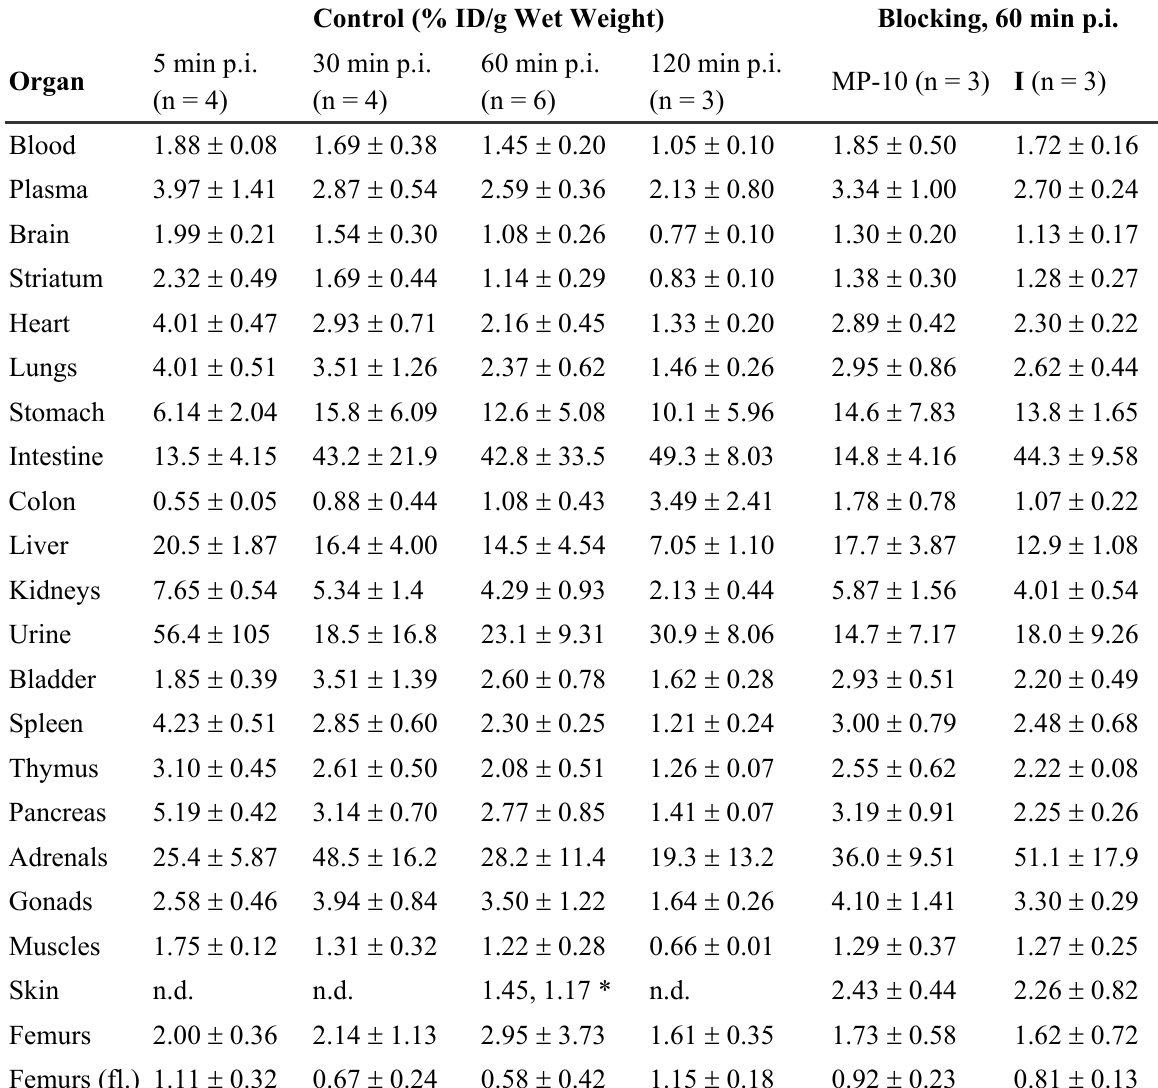
Table 2. Biodistribution of [ 18 F] IV in mice after injection of ~300 kBq without or with preadministration of 10 mg